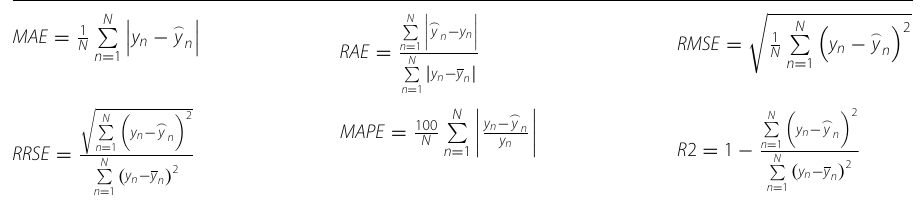
Table 3 Evaluation